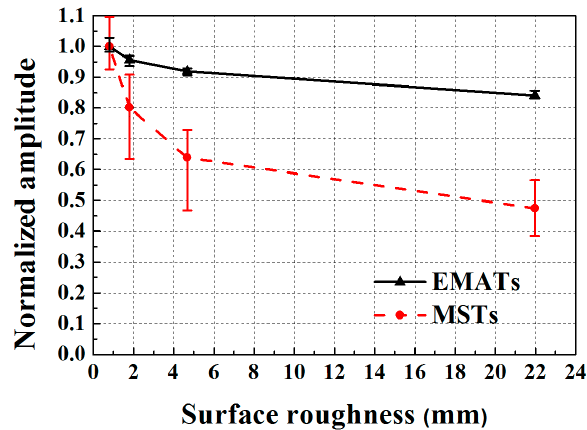
Figure 13. The normalized amplitudes of SH waves for EMATs and MSTs as a function of surface roughness.